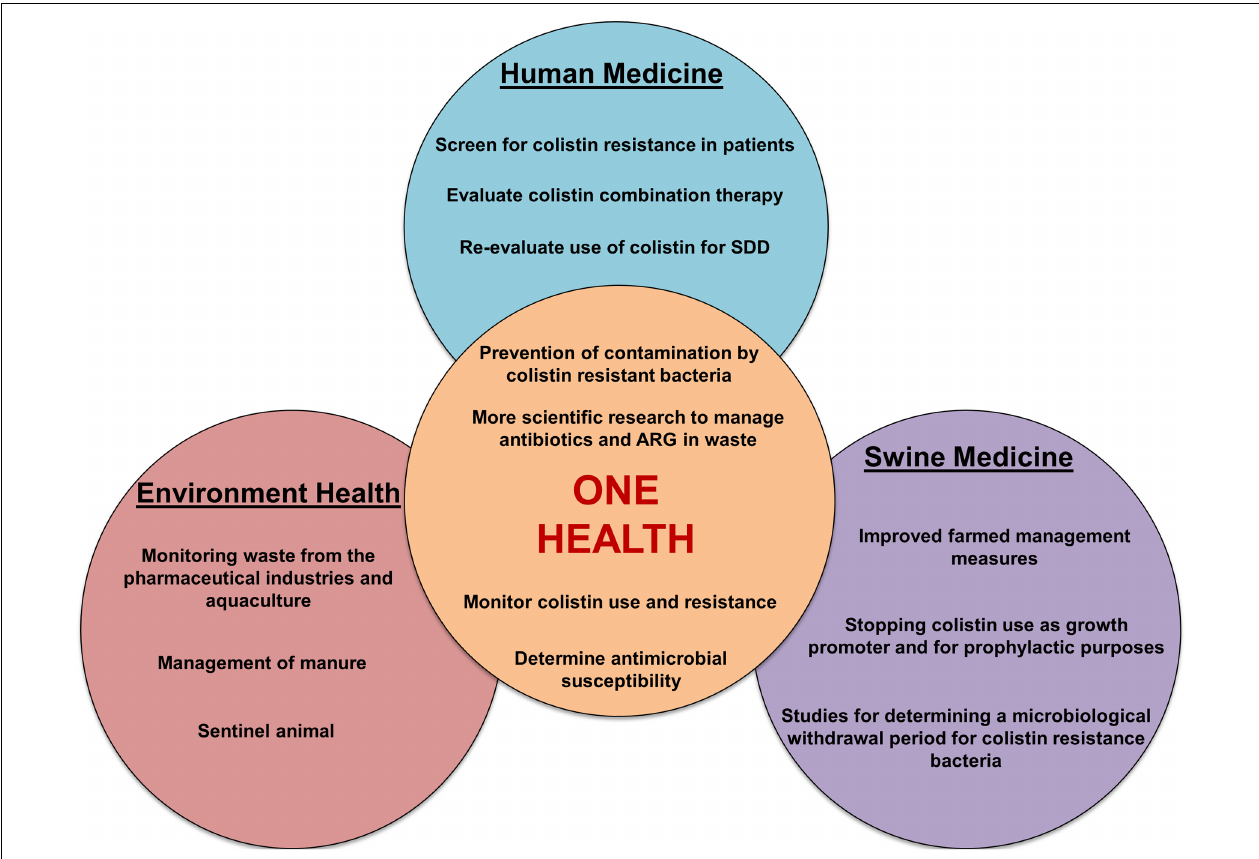
FIGURE 3 | Schematic representation of various actions to be undertaken to ensure reliable management of colistin resistance in a One Health perspective. SDD, selective decontamination of the digestive tract; ARG, antibiotic resistance